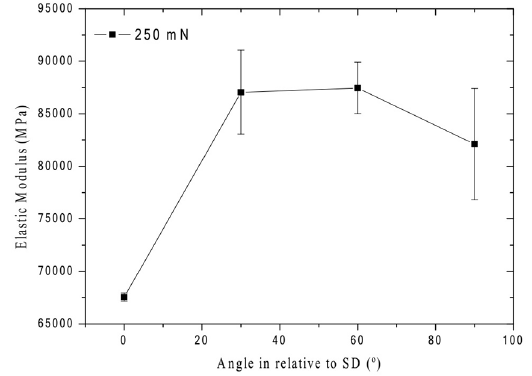
Figure 4. Elastic modulus as a function of solidification direction.